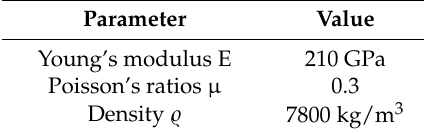
Table 1. Material properties of the resonator.